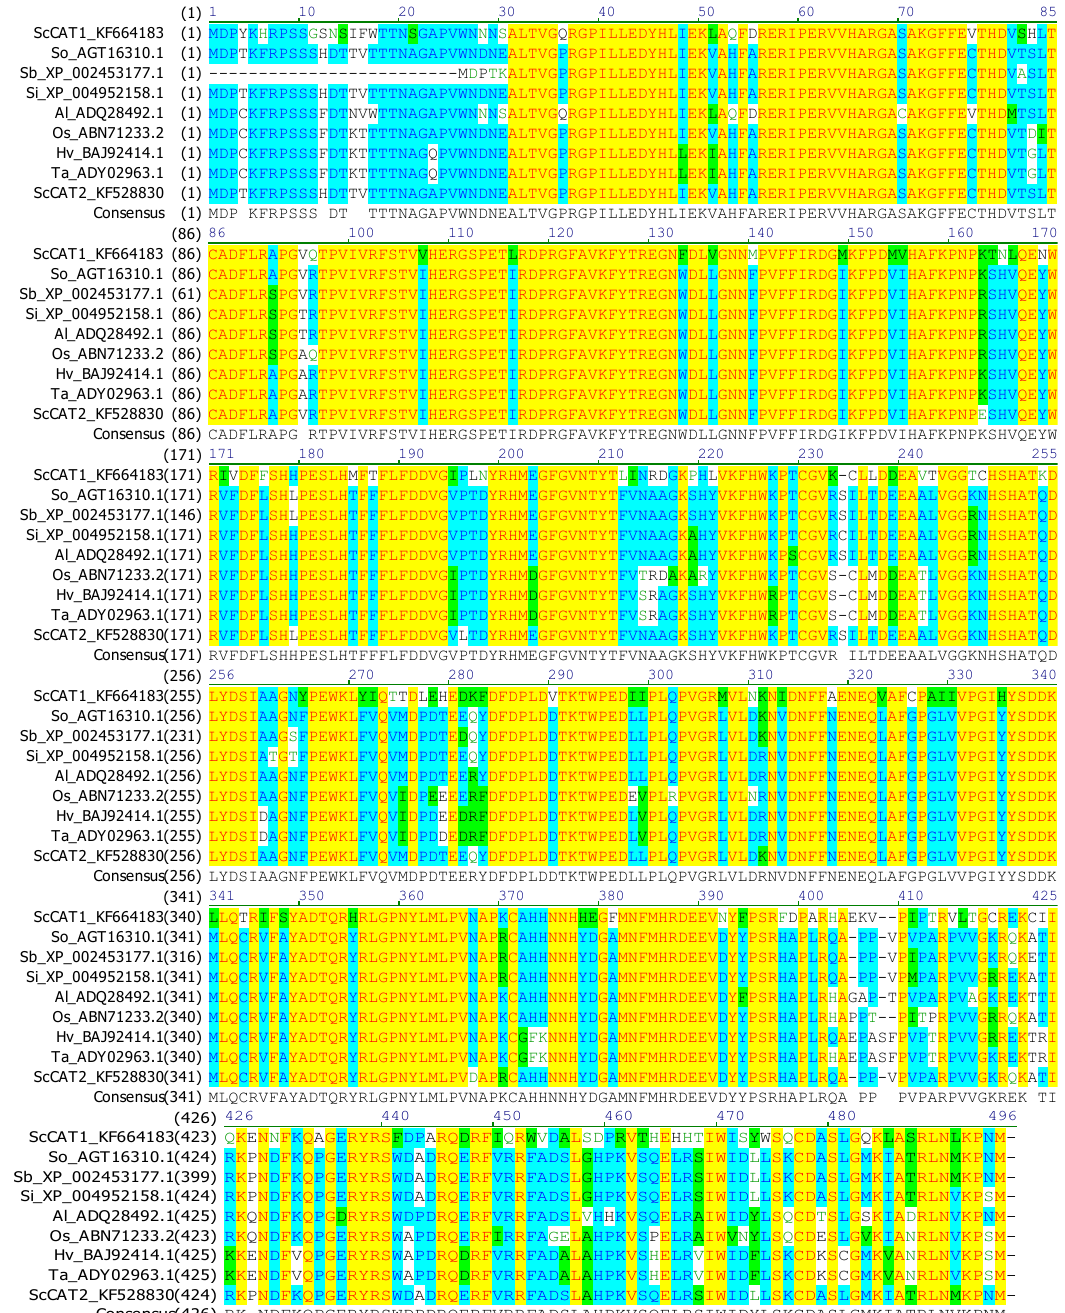
Figure 2. Protein sequence and homology of ScCAT2 with catalases from sugarcane and other